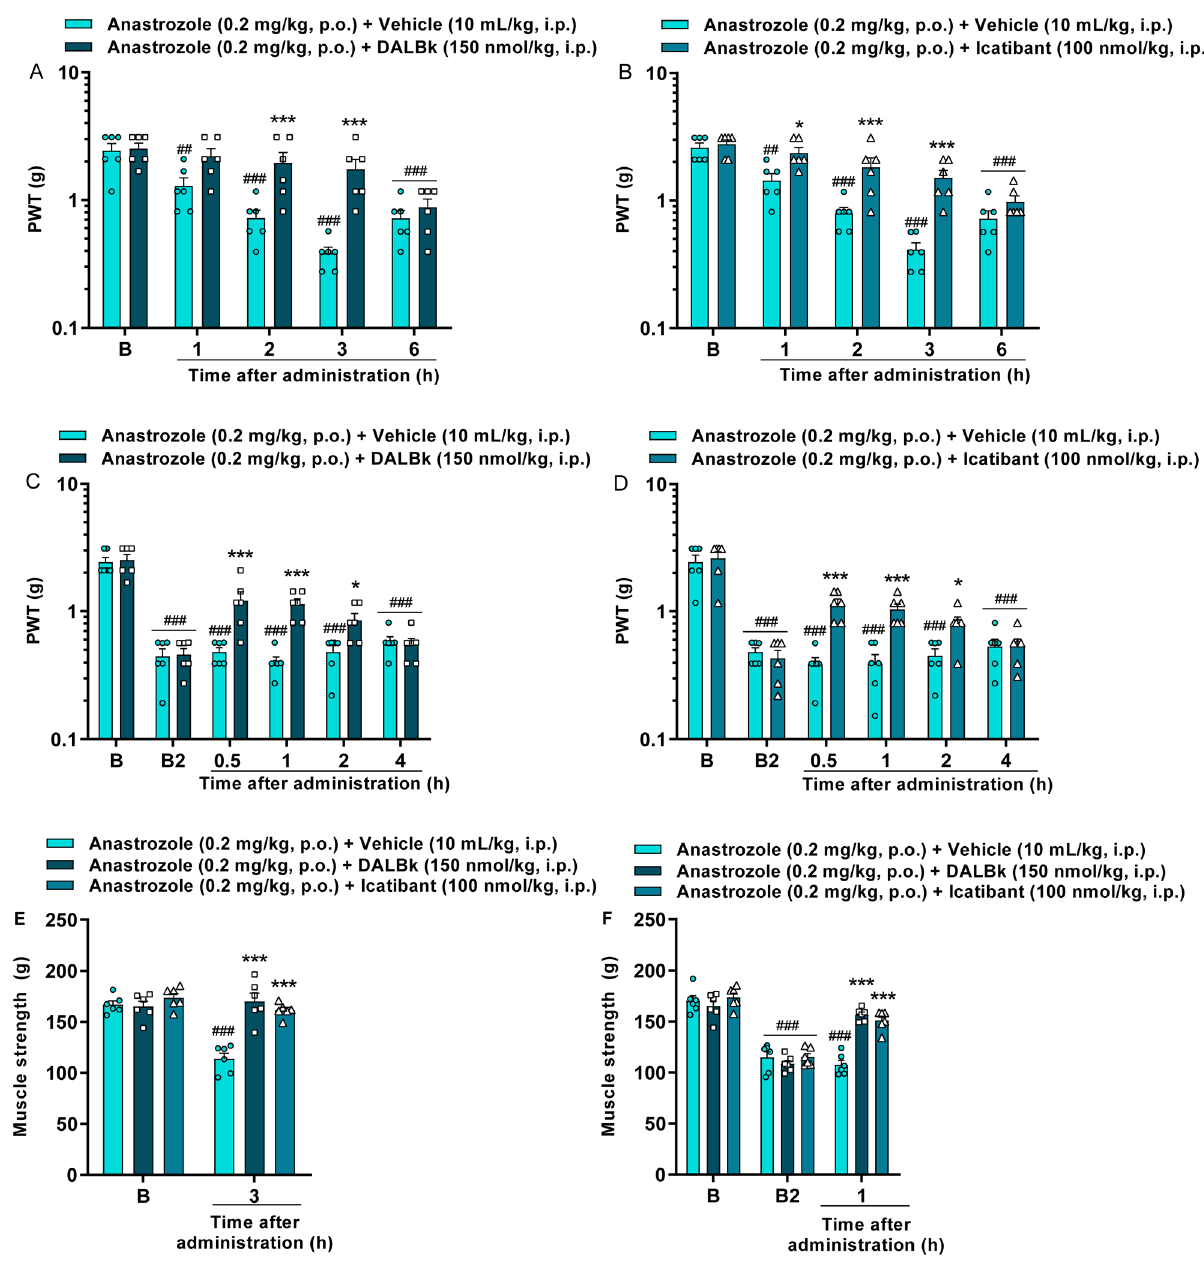
Figure 2. Kinin B 1 (DALBk 150 nmol/kg, i.p.) and B 2 (Icatibant 100 nmol/kg, i.p.) receptor antagonists relieve mechanical allodynia and reduction on the muscle strength caused by the aromatase inhibitor anastrozole (0.2 mg/kg, p.o.). Time-response curve for mechanical allodynia after treatment with DALBk or Icatibant injected 15 min before anastrozole administration ( A , B ). Time-response curve for mechanical allodynia after treatment with DALBk or Icatibant injected at 2 h after anastrozole administration ( C , D ). Measure muscle strength after treatment with DALBk or Icatibant injected 15 min before ( E ) or 2 h after ( F ) anastrozole administration. (B) Denotes baseline mechanical threshold or muscle strength before drug administration; B2 indicates baseline threshold at 2 h after anastrozole administration. Results are presented as mean + SEM (n = 6/group; C57BL/6 mice). ## P < 0.01; ### P < 0.001 compared to baseline threshold (B). *P < 0.05; ***P < 0.001 compared to the vehicle group. Two-way ANOVA repeated-measures followed by Bonferroni’s post hoc test. PWT paw withdrawal